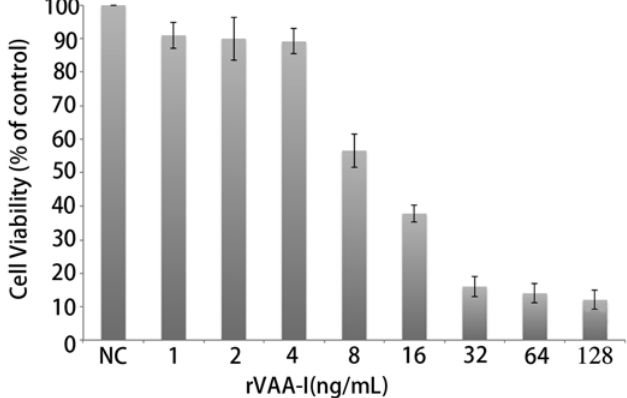
Figure 2. Inhibition of cell growth of SMMC-7721 cells treated with rVAA-I . SMMC-7721 cells treated with a range of rVAA-I concentrations (1.0–128.0 ng/mL) for 24, 36, 48 and 72 h. Viability was measured with MTT reagent after the indicated period